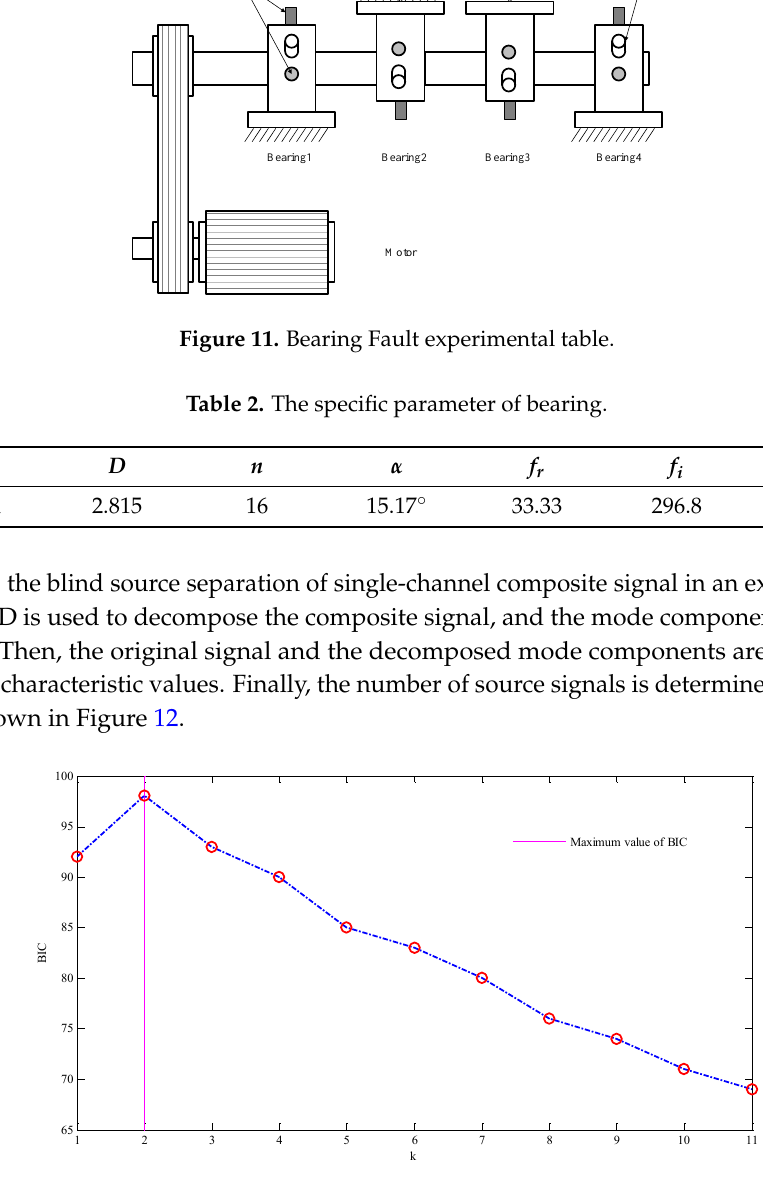
Figure 12. The BIC value of experimental signal.